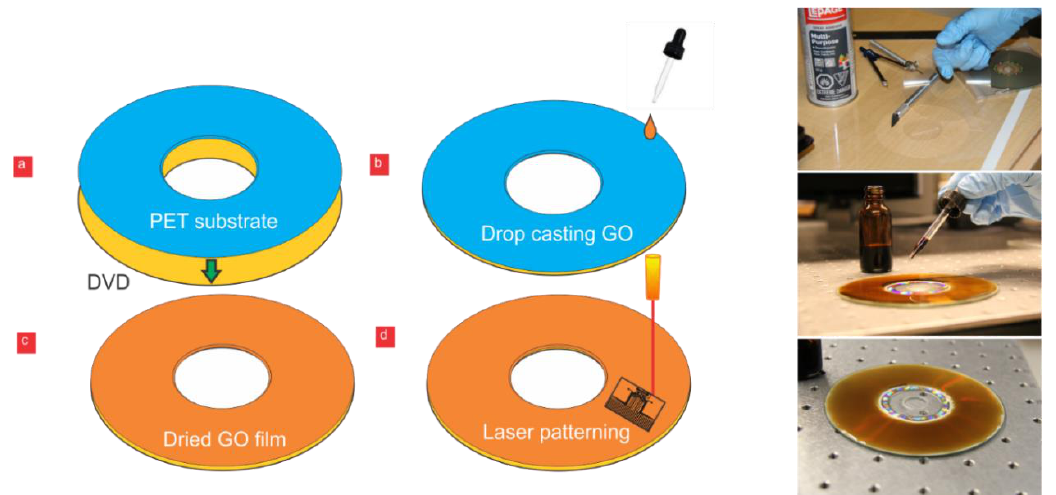
Figure 2. ( a ) polyethylene terephthalate (PET) substrate fixed on top of the LightScribe compact disc (CD). ( b ) Graphene oxide (GO) solution dispensed. ( c ) The substrate was left to dry for 24 h. ( d ) The CD was inserted into the laser-scribing drive, where the laser was used to form the required patterns. On the right-hand side are the steps for drop casting the graphene oxide on the PET substrate affixed on top of a CD. The PET substrate was cut and placed on a CD; then, the GO solution was drop casted and left to dry.